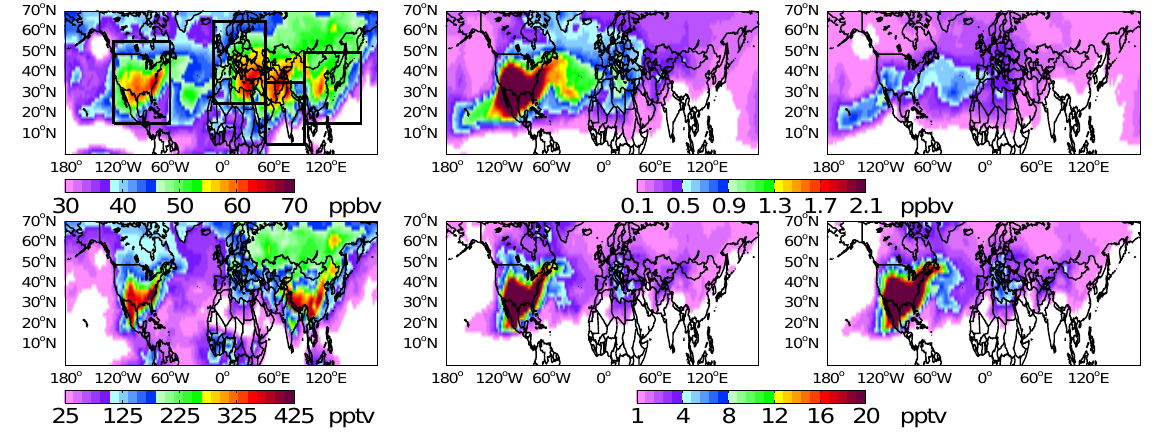
Fig. 2. Same as Fig. 1 but for